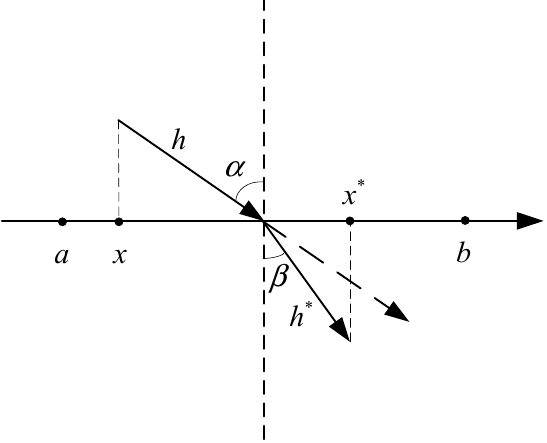
Figure 5. Principle of Refraction.